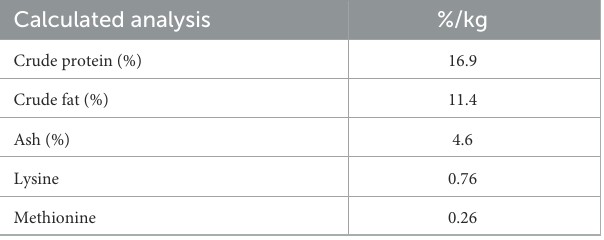
TABLE 2 Nutrient composition of PreSuin pro, NutriSuin ® .